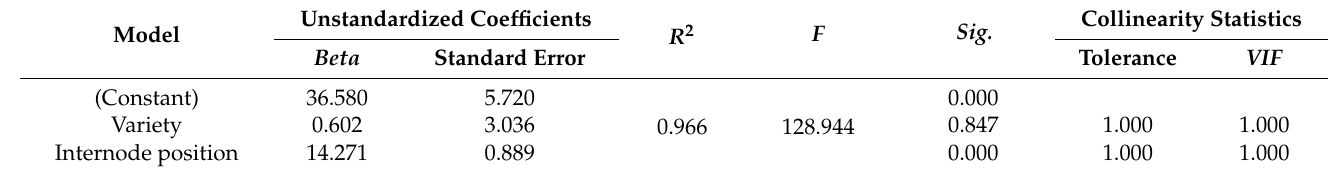
Table 6. Table of regression coefficients of the axial distance of banana hands.